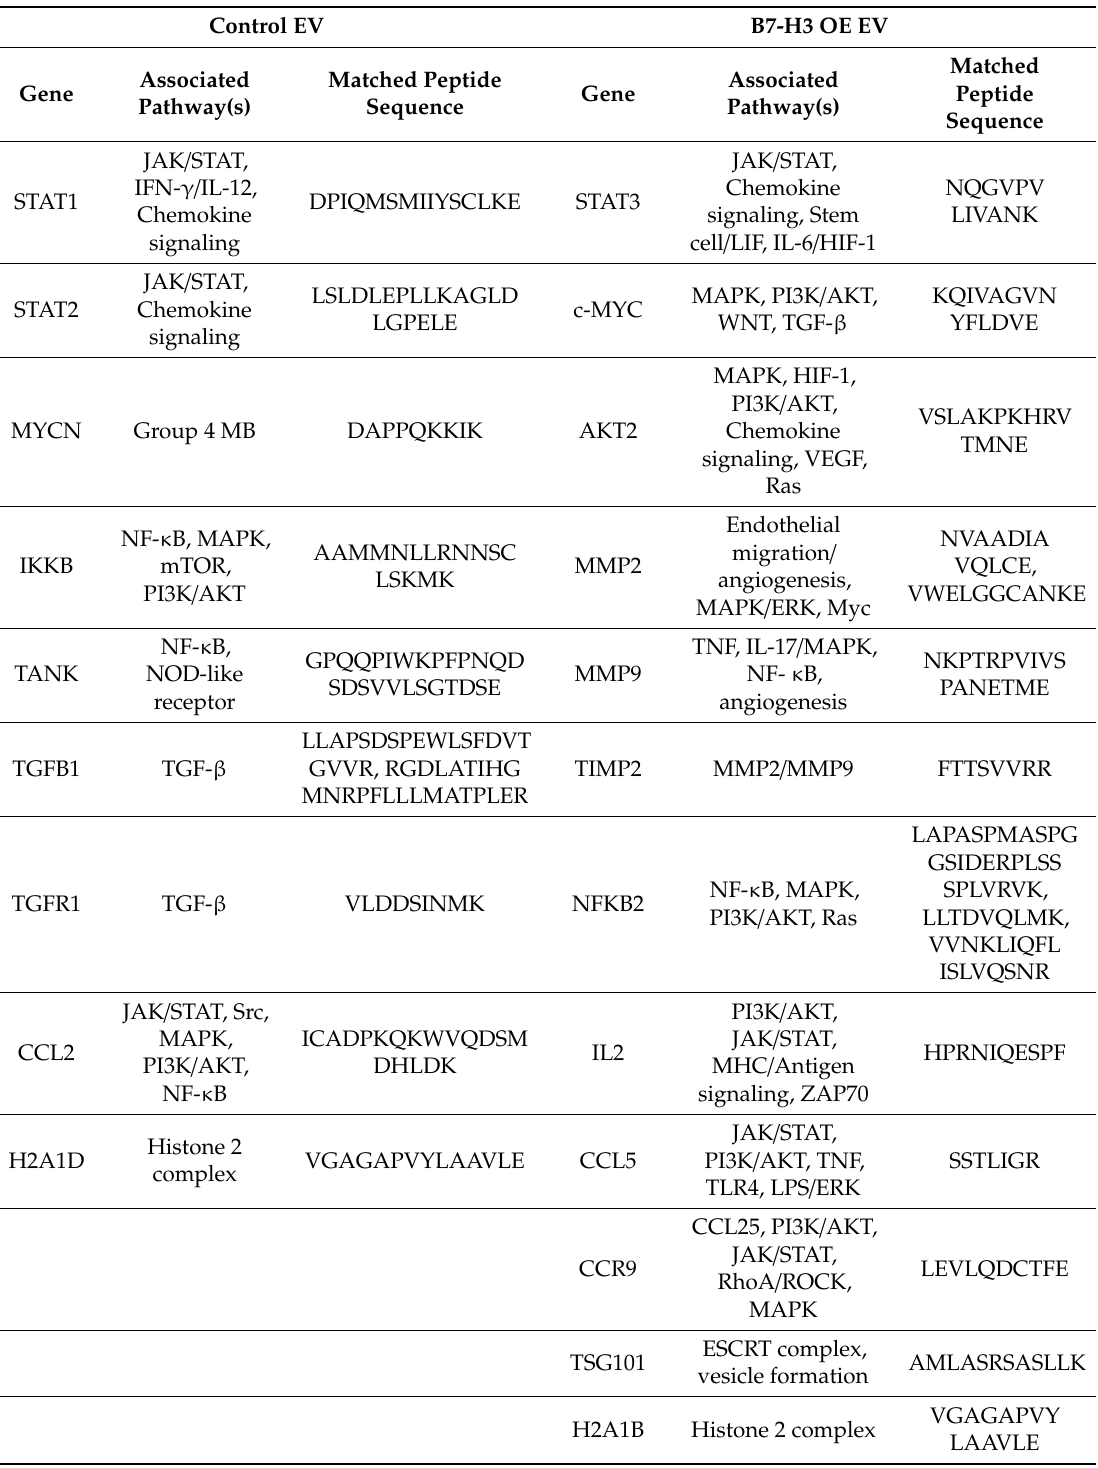
Table 1. Exosomal Mass Spectrometry